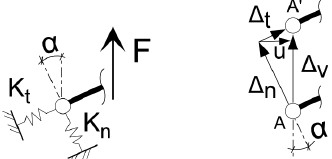
Figure 7. Calculation scheme of the resultant stiffness K